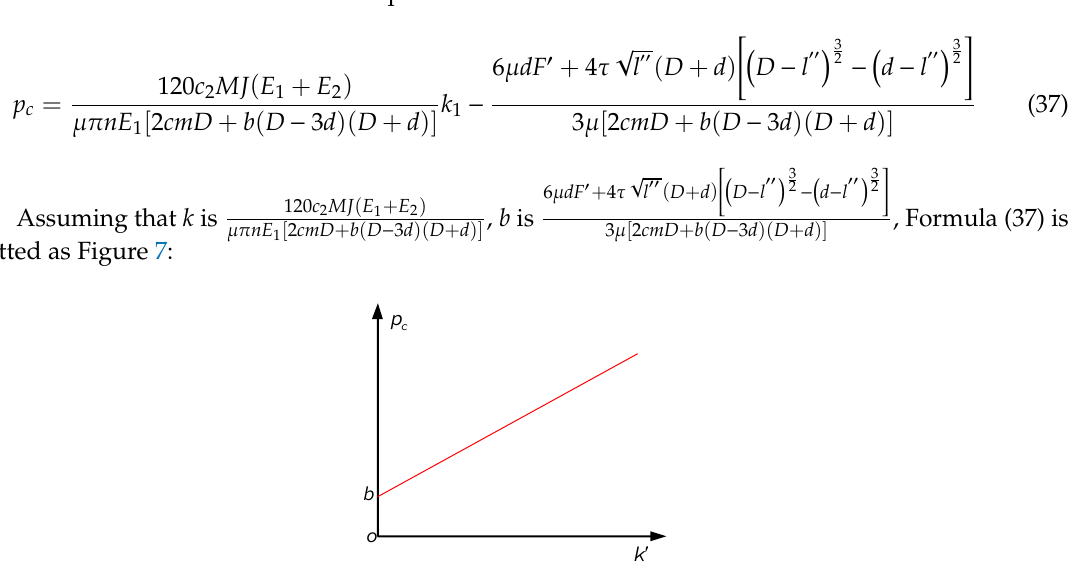
Figure 7. Diagram of the relationship between change rate of the bit temperature and the stress of the coal rock.